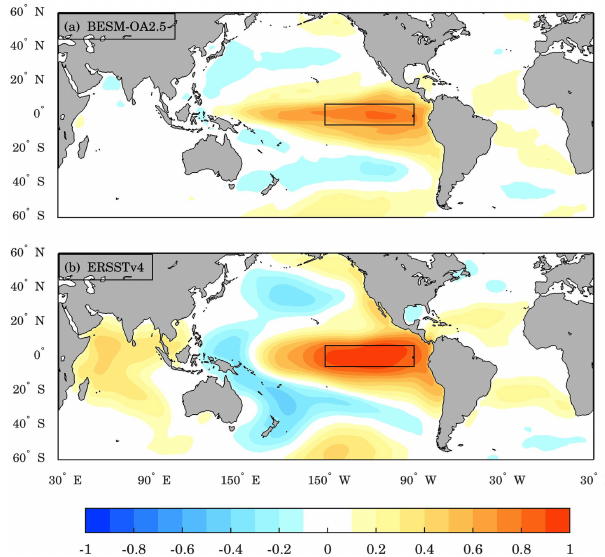
Figure 17. Spatial maps with the monthly correlations between the Niño-3 index and the global SST anomalies computed by (a) BESM-OA2.5 and (b) ERSSTv4 over the period 1900–2005. The anomalies were obtained by subtracting the monthly means for the entire detrended time series at each grid point. Black rectangles show the Niño-3 index region. Shaded areas are statistically signif- icant at the 95% confidence level (based on two-tailed Student’s t